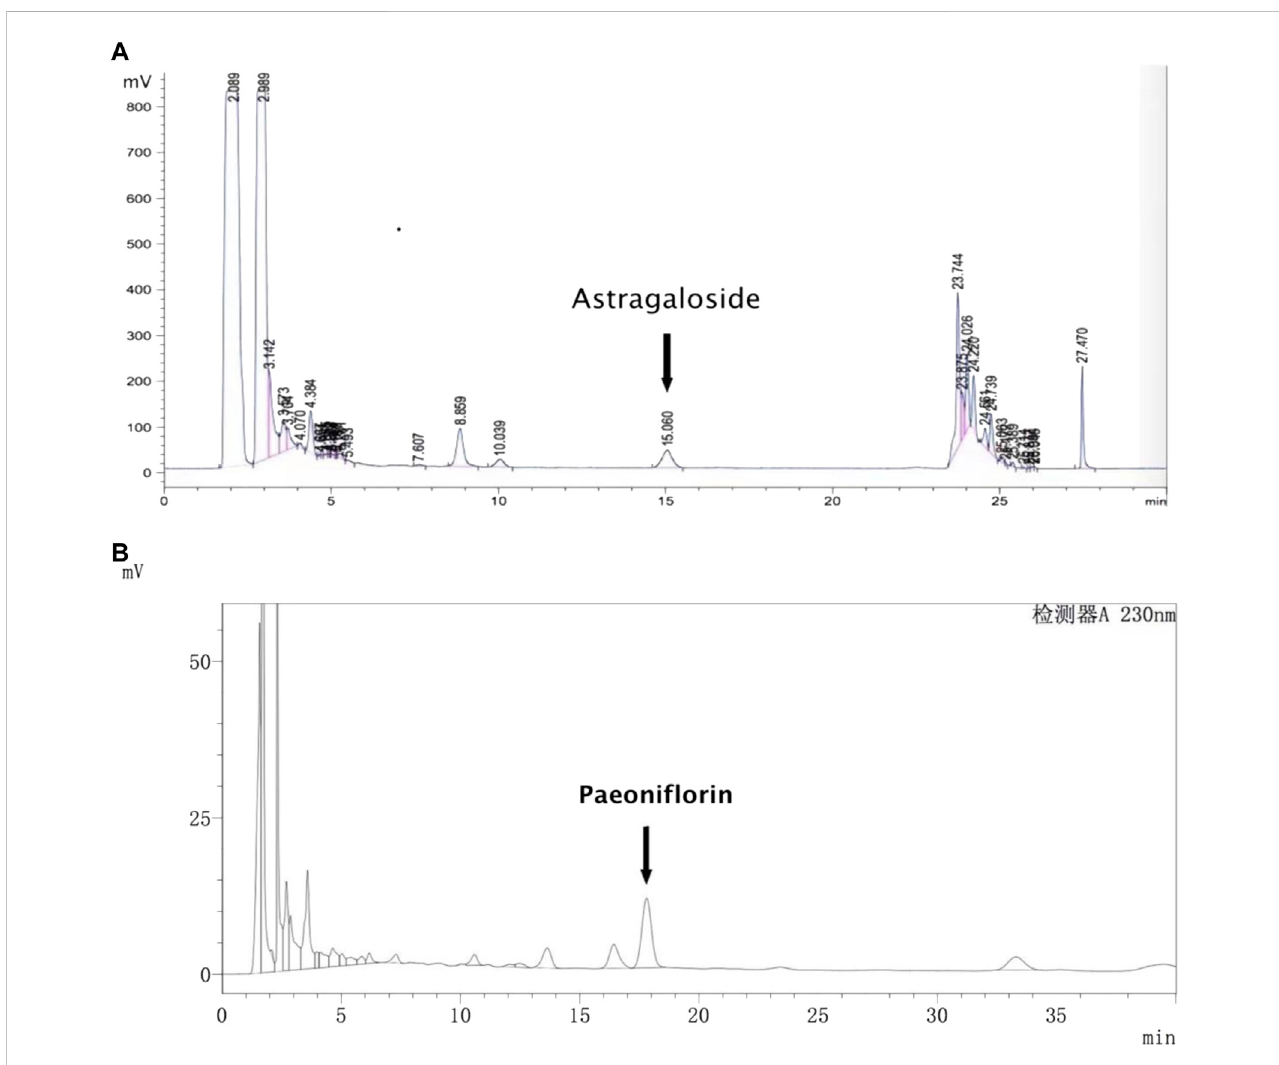
FIGURE 1 HPLC chromatogram of astragaloside (A) and paeoni fl orin (B) .